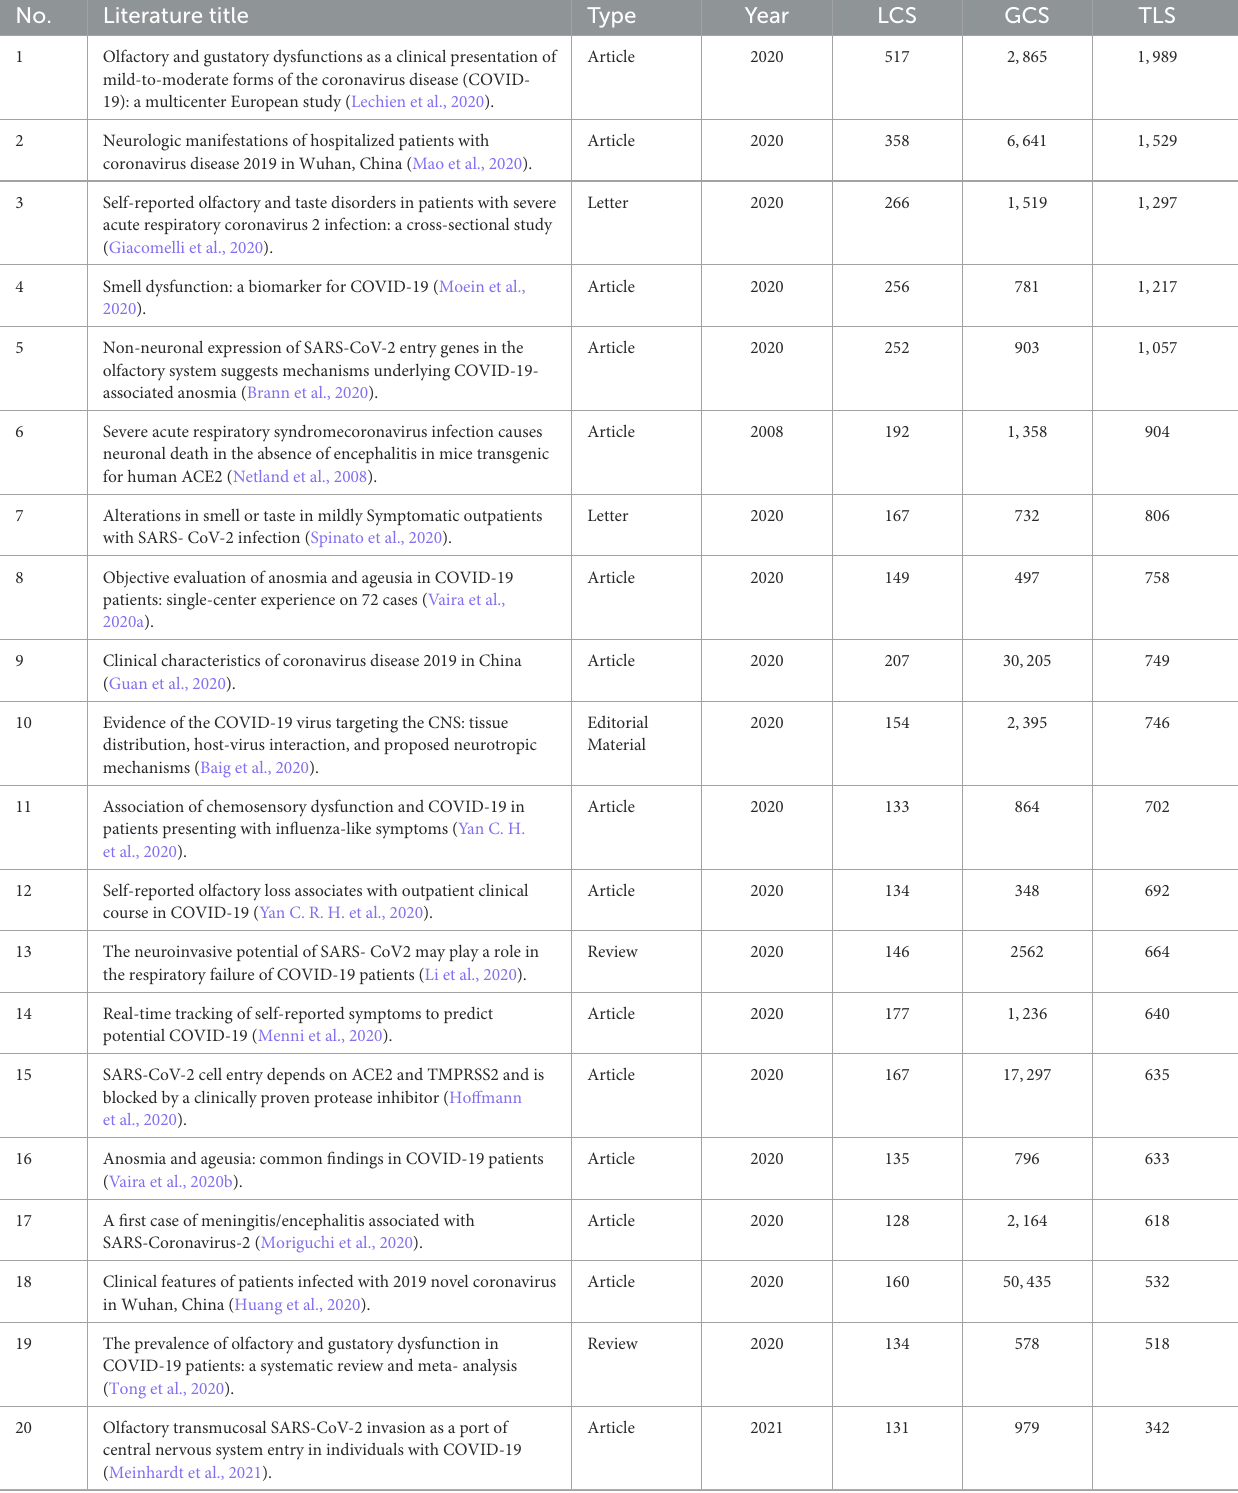
(Meinhardt et al., 2021).